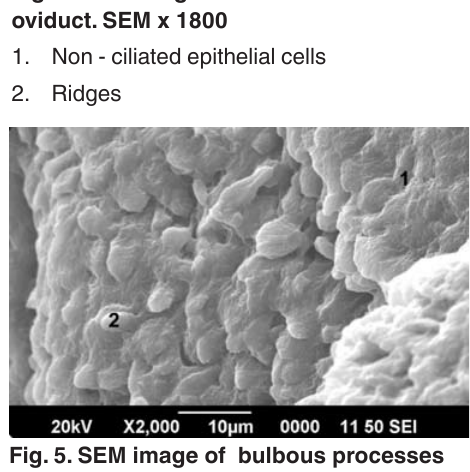
Fig. 5. sEm image of bulbous processes on the surface of non-ciliated cells of oviduct. sEm x 2000